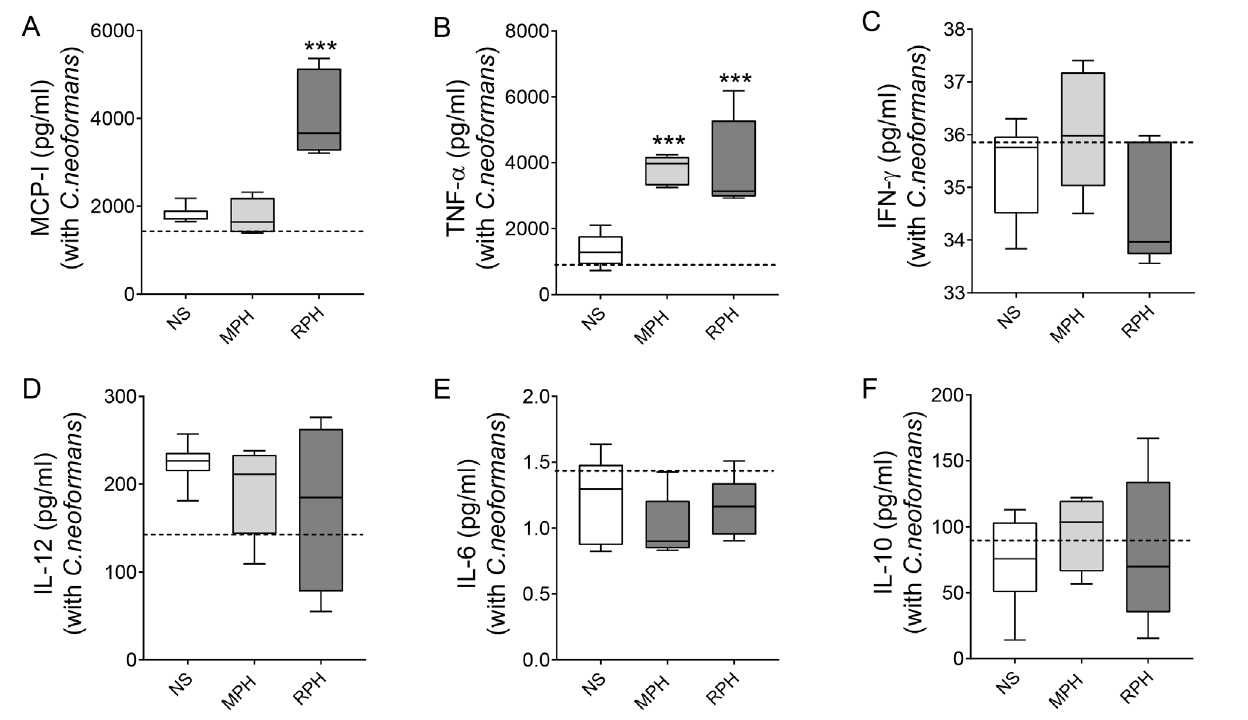
Figure 6. MCP-I/TNF-α levels are still increased 48 hours after incubation with hemolymph. The supernatant of RAW 264.7 cells incubated with C. neoformans was collected 48 hours after culture, and the production of the following cytokines was analyzed: (A) MCP-I; (B) TNF-α; (C) IFN-γ; (D) IL-12; (E) IL-6 and (F) IL-10. Data representative of one experiment. The significances are relative to the NS group. * p < 0.05; ** p < 0.01; *** p <